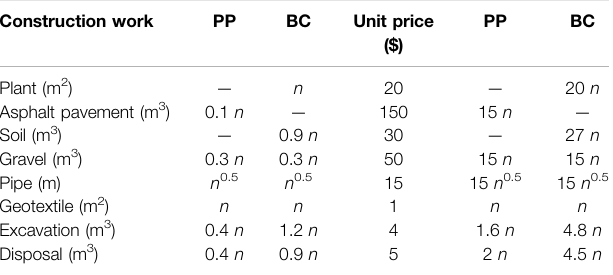
TABLE 3 | Construction costs of constructed wetland ( n m 2 ) and permeable pavement ( n m 2 ) used in this